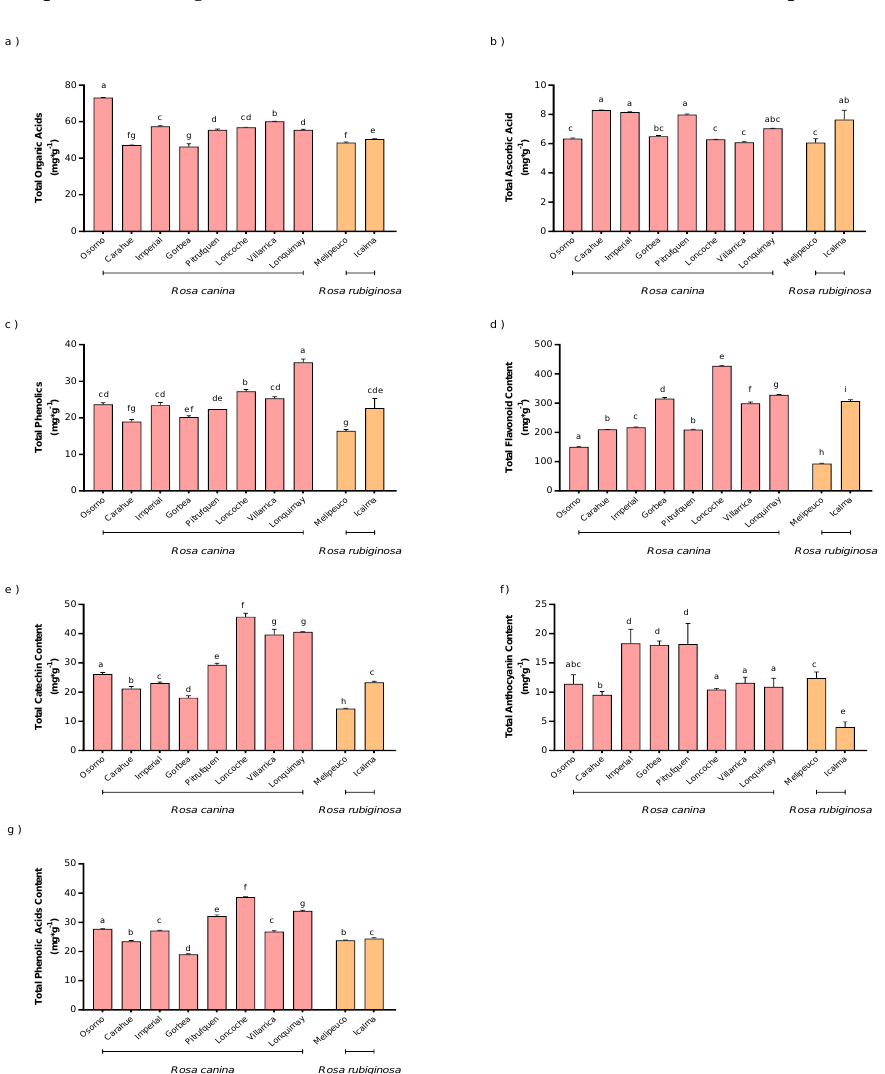
Figure 1. Contents in fruits of Rosa spp.: ( a ) organic acids; ( b ) ascorbic acid; ( c ) total phenolic; ( d ) flavonoid; ( e ) catechin; ( f ) anthocyanin; ( g ) phenolic acid content. Concentrations were expressed as fresh weight (FW). Different letters in each sub-figure indicate the presence of statistically significant differences according to the Tukey’s multiple range test ( p ≤ 0.05; n = 9).